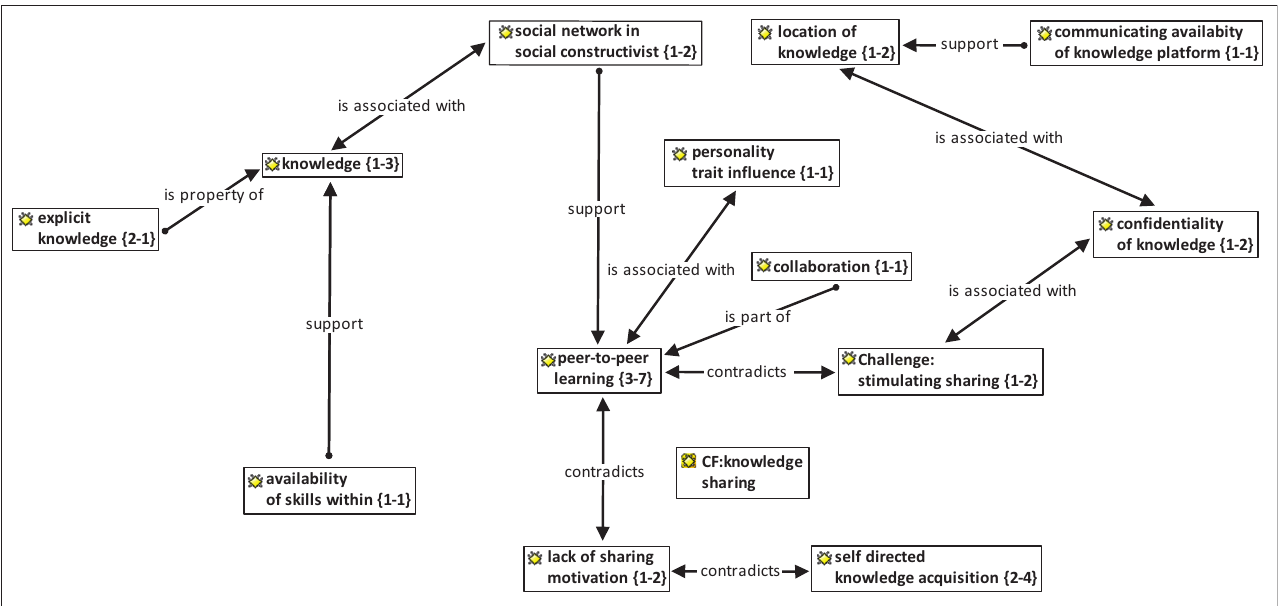
FIGURE 2: Network showing collaborative engagement in the South African public